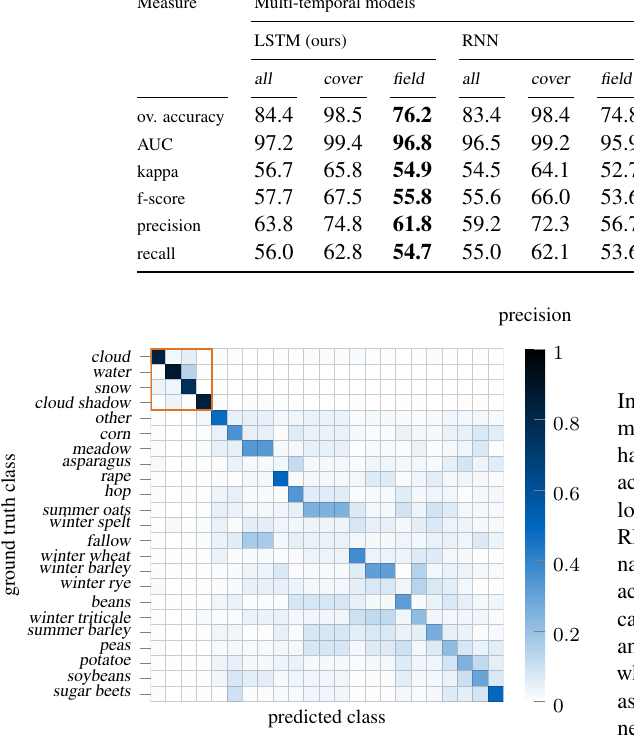
Figure 8. Confusion matrix of SVM classification. While covered classes, indicated by the orange-framed submatrix, have been classified well, field classes were confused